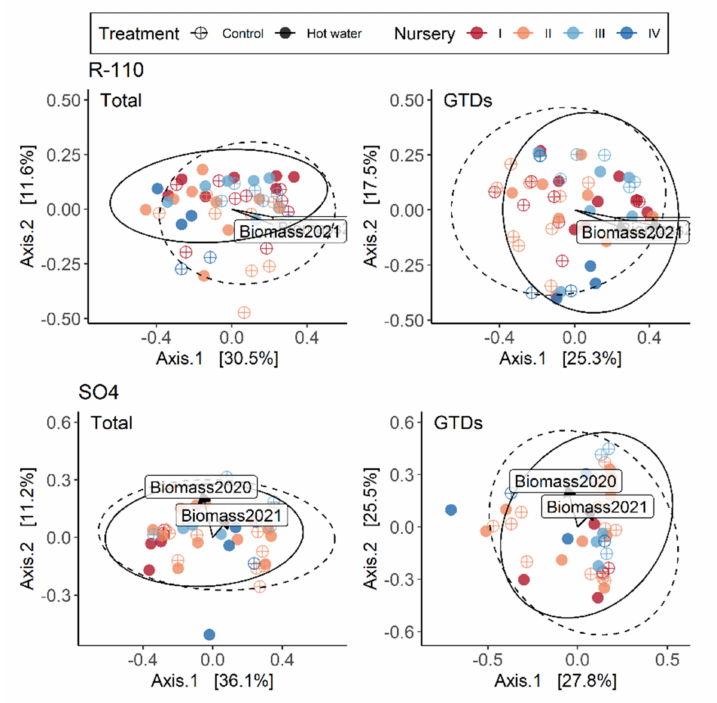
Figure 7. PCoA ordinations calculated with a Bray-distance matrix showing the contribution of rootstocks R-110 ( top ) and SO4 ( bottom ) to variation in the total fungal community ( left ) and the GTD-related ( right ) fungal community in each nursery and for each treatment in root collars. The R 2 and p -values shown are extracted from a PERMANOVA analysis performed with the adonis2 function in R. Table 7. Indicator species for Xarel · lo plants in both tissues for control and HWT plants. Correlation values (stat) and the statistical significance of the correlation ( p -values) are shown. GTD-related indicator species are marked with a cross (†) and biocontrol species are marked with an asterisk (*). The annotation denoting the significance level is as follows: *** <0.001, ** <0.01, *